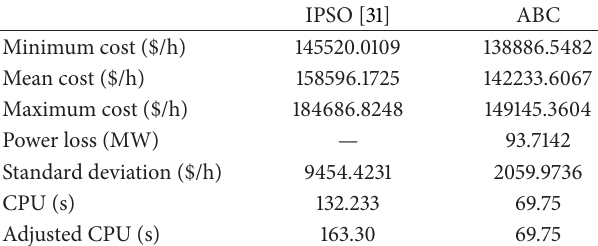
Table 4: Result comparison for the IEEE 118-bus system.